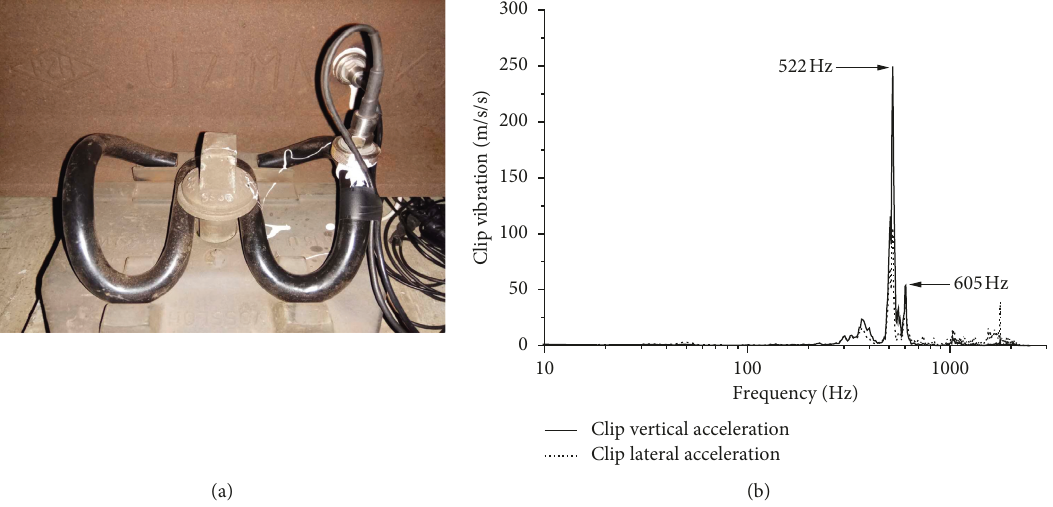
Figure 14: On-site test (a) and output (b) of frequency contents of rail clip vibration.